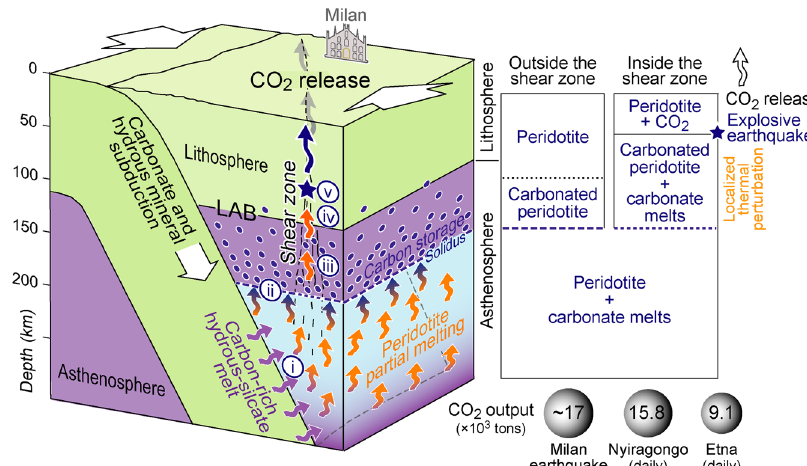
Fig. 4 The fate of deeply stored carbon after cold subduction in fi ve steps. i) Carbon-rich hydrous-silicate melts, generated by the breakdown of subducted carbonates and hydrous minerals along the slab interface, in fi ltrate the mantle wedge inducing peridotite partial melting. ii) The carbon-rich melts lead to extensive peridotite carbonation and the formation of a carbon reservoir in the asthenospheric upper mantle at depths less than ~180 km 3 . iii) Minor thermal perturbations along upper-mantle shear zones allow remobilization of carbon-rich melts. iv) Melts ascend along the shear zone owing to their low viscosity until they exit the carbonate stability fi eld. v) Explosive earthquakes reveal consequent rapid CO 2 release in the lithospheric mantle. In the lithospheric mantle outside the shear zone, melts are not generated. The gray spheres compare the CO 2 output towards Earth ’ s surface calculated for the Milan earthquake (~17,000 tons) with the daily CO 2 emissions of the top-ranking most actively degassing volcanoes Nyiragongo and Etna 41 . Image generated using Inkscape 1.0